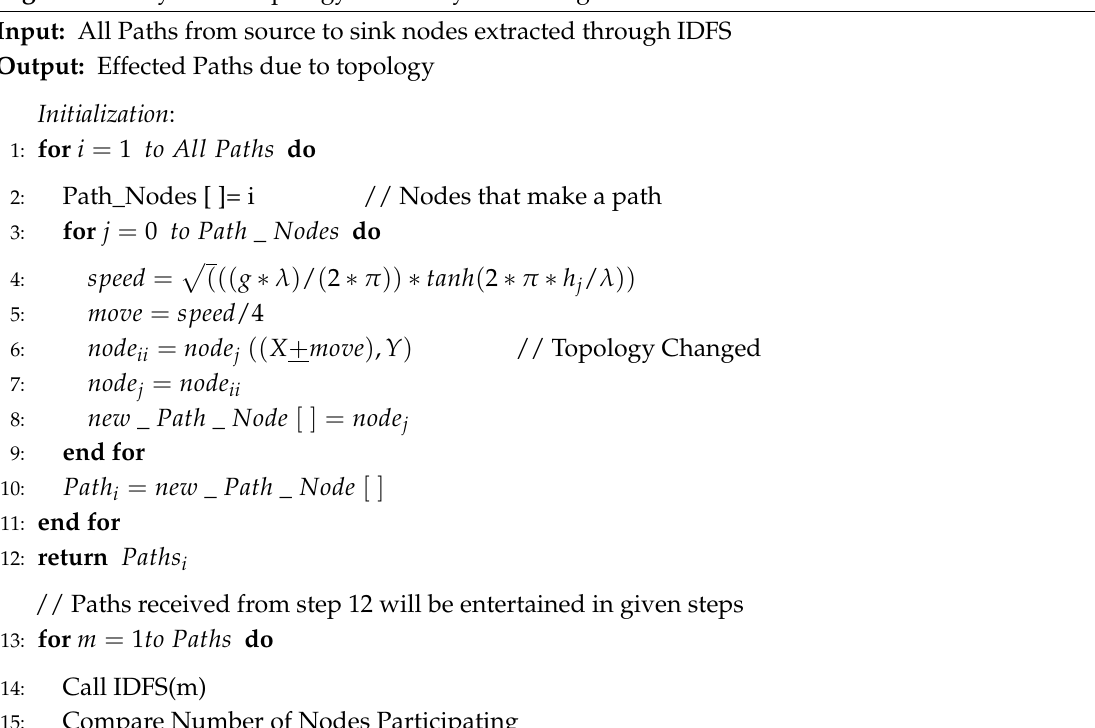
Algorithm 2 Dynamic Topology Discovery of Existing